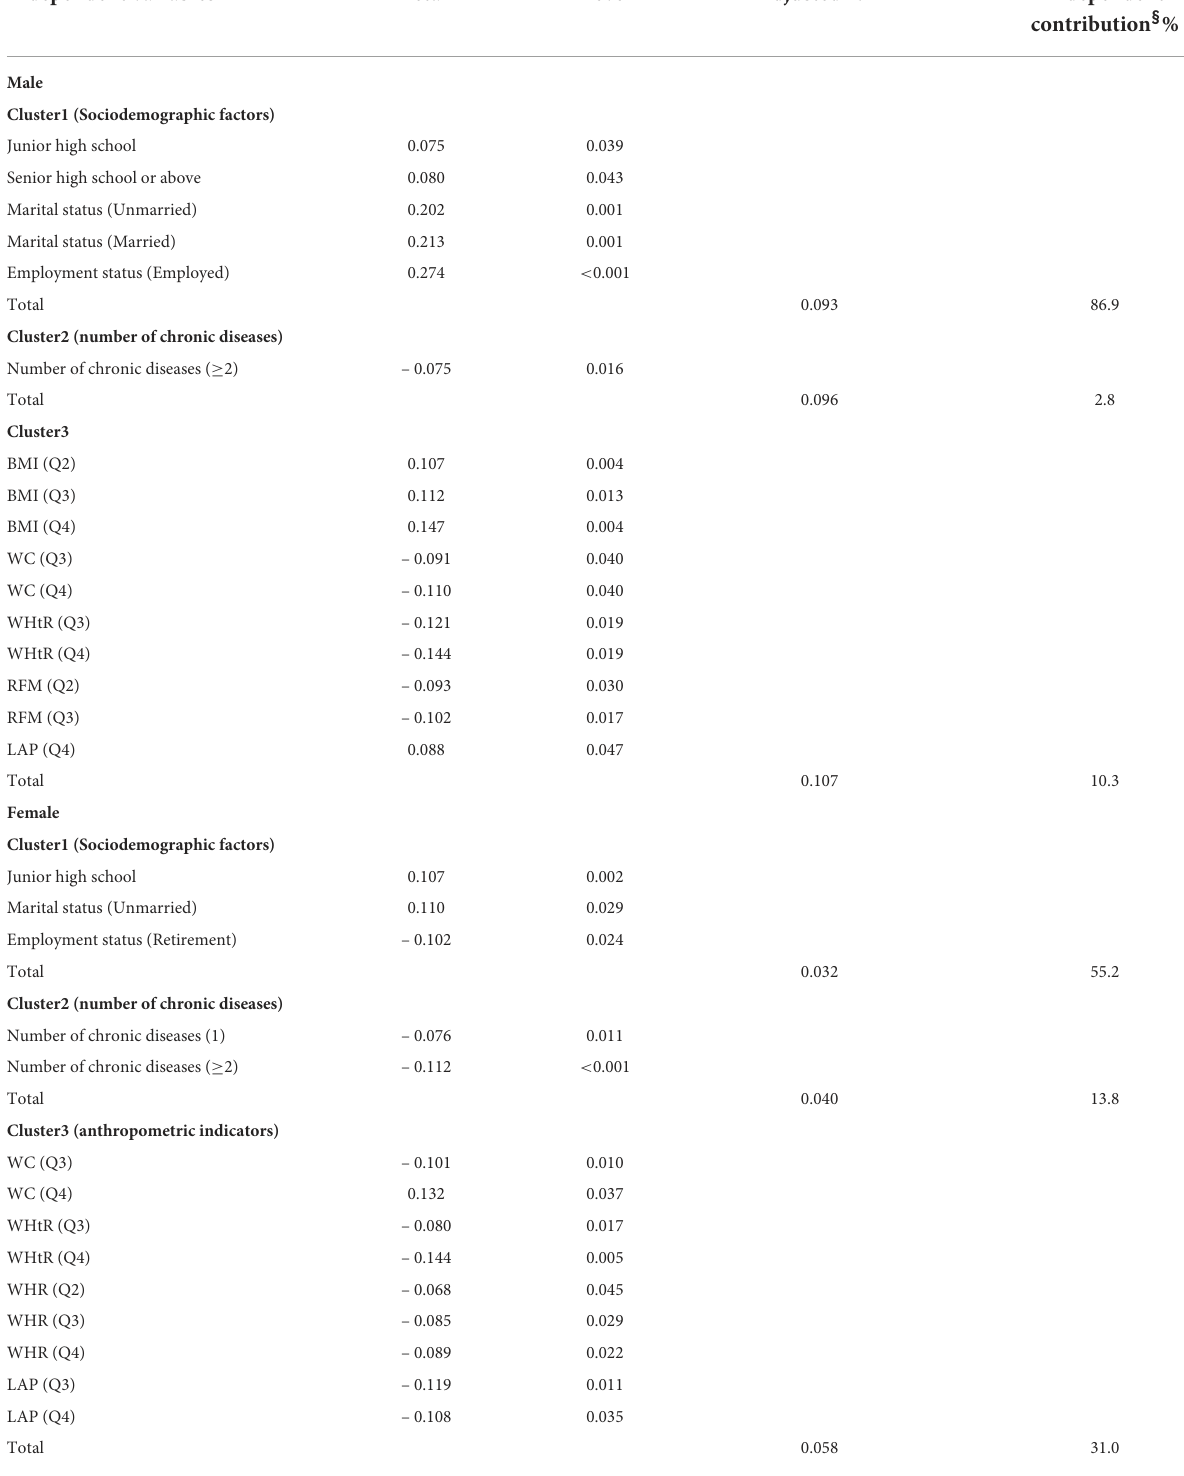
TABLE 4 Clustered multiple linear regression analysis of the HRQoL of male and female community residents ( n = 2,663). Independent